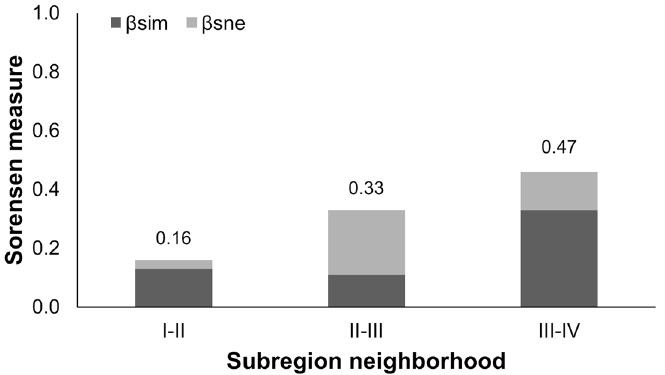
Figure 4. Pairwise comparisons of incidence-based measures of two beta diversity components, species turnover ( β SIM ) and nestedness ( β SNE ), of bat roadkills between neighbors of five elevation subregions: (I) 0–100 m, (II) 100–500 m, (III) 500–1500 m, and (IV) >1500 m, in Taiwan from 2013 to 2018. Numbers above bar denote the overall beta diversity measure of each subregion pair